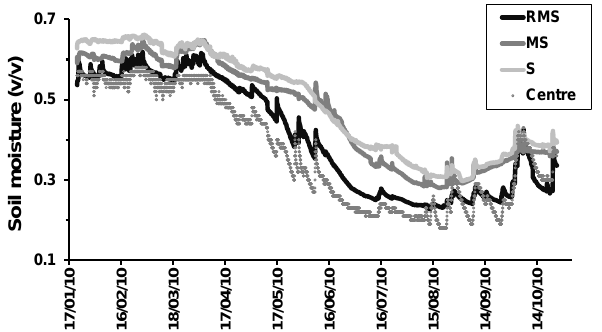
Fig. 2. Seasonal changes of soil volumetric moisture content ( v / v ) at the Straits Enclosure, Alice Holt forest in 2010 measured hourly at 6cm depth for three replicated ( n = 4) soil collar treatments (sur- face collar, RMS), mycorrhizal 41µm mesh bag (MS) and steel col- lar (S) and in the undisturbed central area (Centre). The average SE was ∼ 0.02 ( v / v ) for all treatments (not shown for clarity).